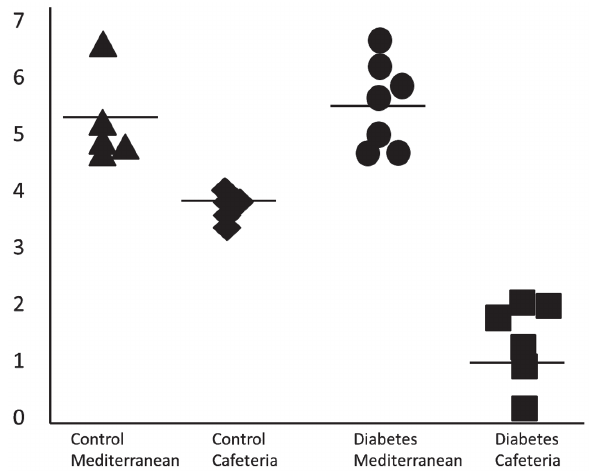
TG postprandial Number of peaks showing correlation . 0.85 ( . 0.9) between protein peak expression levels and physiological parameters in control and diabetic animals fed with the Mediterranean or cafeteria diets. The parameters were measured either 3 hours postprandial or after 16 hours fasting, where indicated. For information on the peak m/z values see file S3. The information after calculating the residuals using a model including effects of diabetes and feed is included. Information about peak similarities is given where appropriate. a: Very Low Density Lipoproteins; b: Low Density Lipoproteins; c: Triglycerides; d: Non Esterified Fatty Acids.